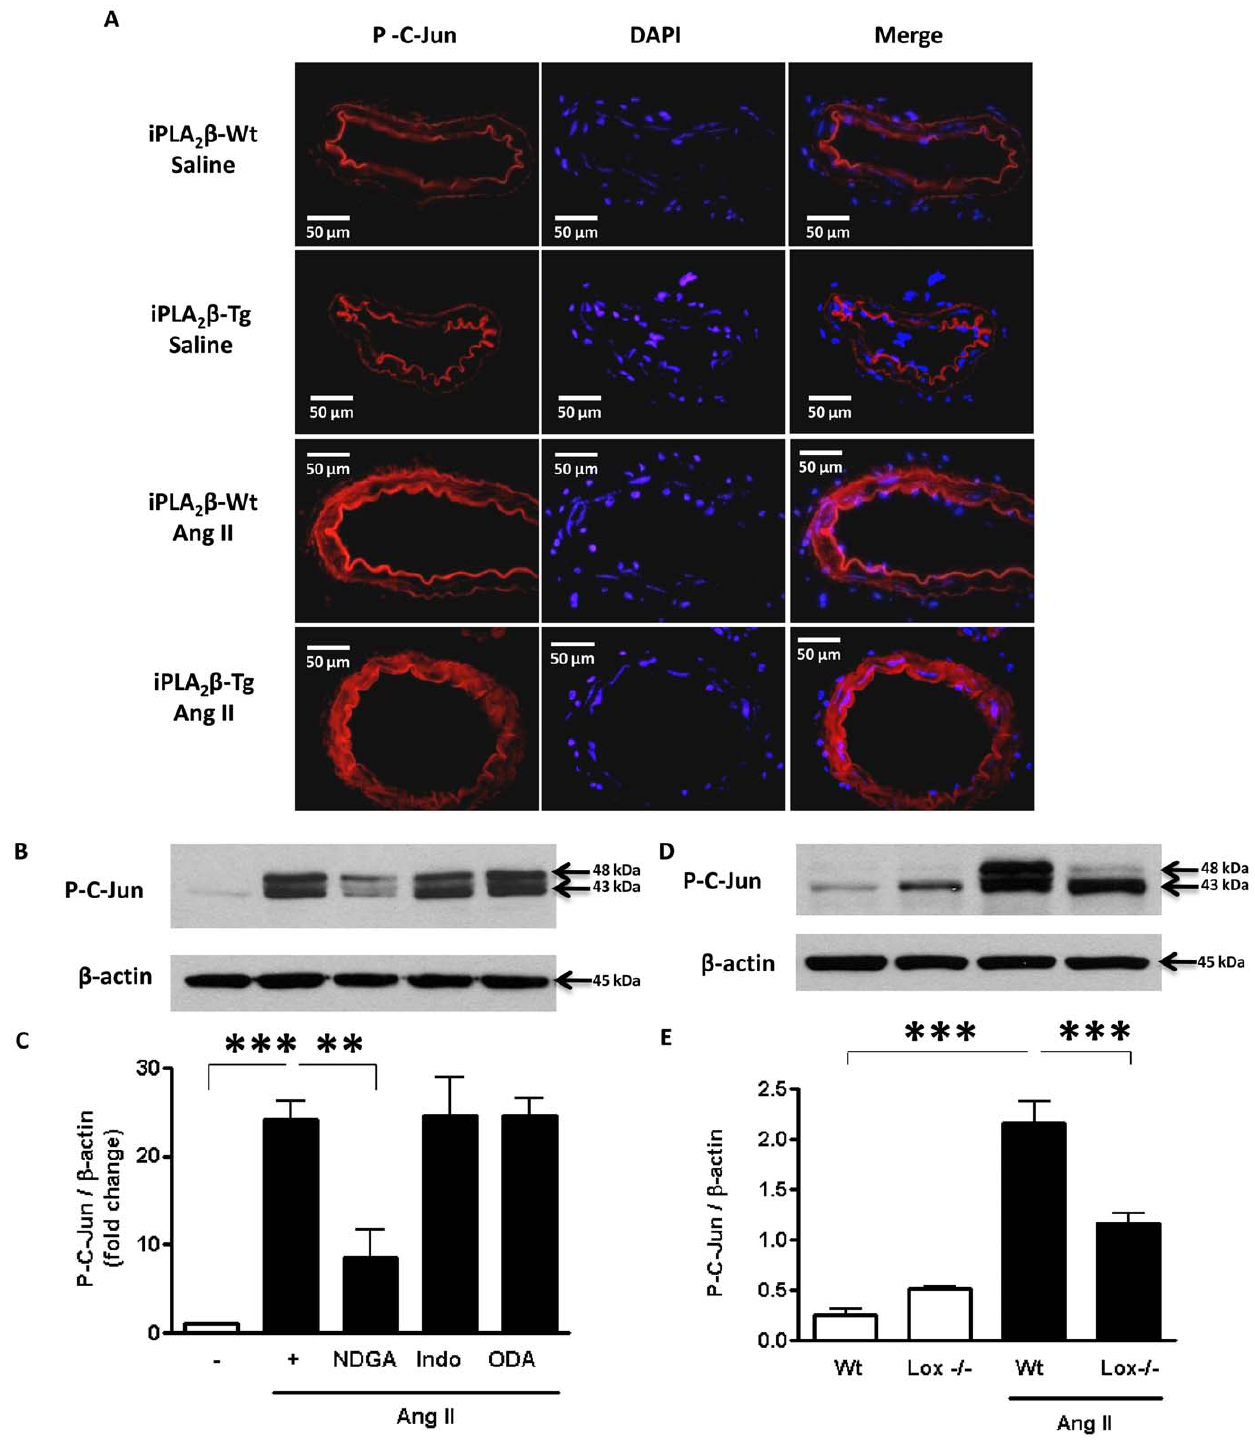
Figure 6. iPLA 2 b overexpression promotes Ang II-induced c-Jun phosphorylation via the 12/15 lipoxygenase pathway. ( A ) iPLA 2 b -Wt and iPLA 2 b -Tg mice were infused with Ang II (1000 ng/kg/min, 14 days) or saline and 2 nd order branch of mesenteric arteries VSMC were isolated and embedded in OCT. Vessel sections were stained with anti-p-c-Jun antibody and DAPI. ( B ) and ( D ) are representative western blots, ( C ) and ( E ) are quantifications of the blots, of c-Jun phosphorylation in aortic VSMCs after the same treatments as in Fig. 3 B and C. n=3–4, *:p , 0.05, **: p , 0.01, ***: p , 0.001 one-way ANOVA.